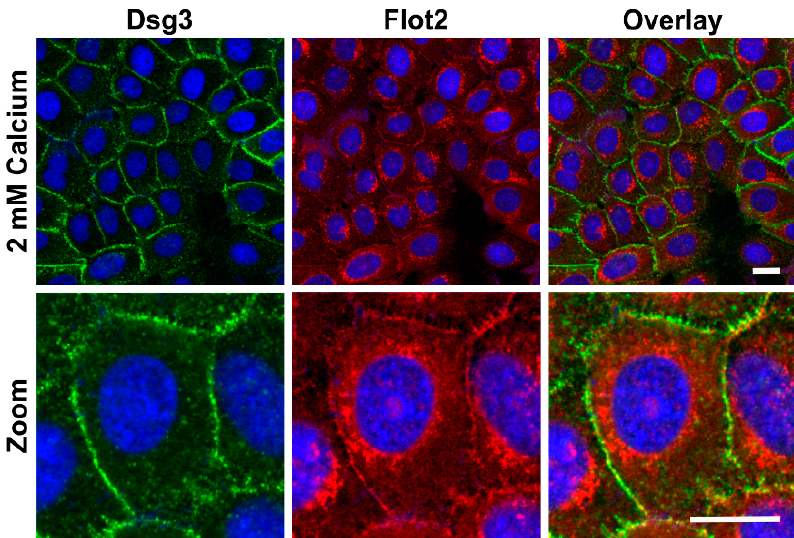
Figure 3. Colocalization of desmogleins and flotillin-2 upon 2 mM calcium in hTert cells. The cells were grown on coverslips in KGM with 0.05 mM calcium for at least four days, and then shifted to 2 mM calcium for 24 h. After MeOH fixation, the cells were stained with anti-Dsg3 (green) and anti-Flot2 (red) antibodies and fluorochrome coupled secondary antibodies (anti-mouse Alexa488 and anti-rabbit Alexa546). The coverslips were mounted in a mounting medium with DAPI. n = 3 independent experiments, scale bar 20 µm.